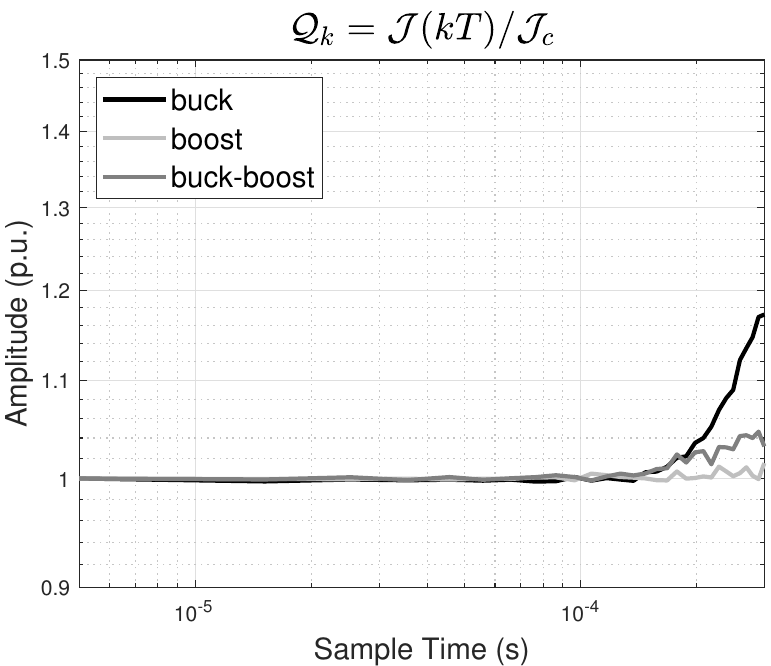
Figure A2. The value of Q is shown in p.u. as a function of the sampling period of a hypothetical microcontroller. The origin of the x -axis represents the system operating under a sampling period closed to 0 s (continuous-time), increasing this period to the right up to 0.3